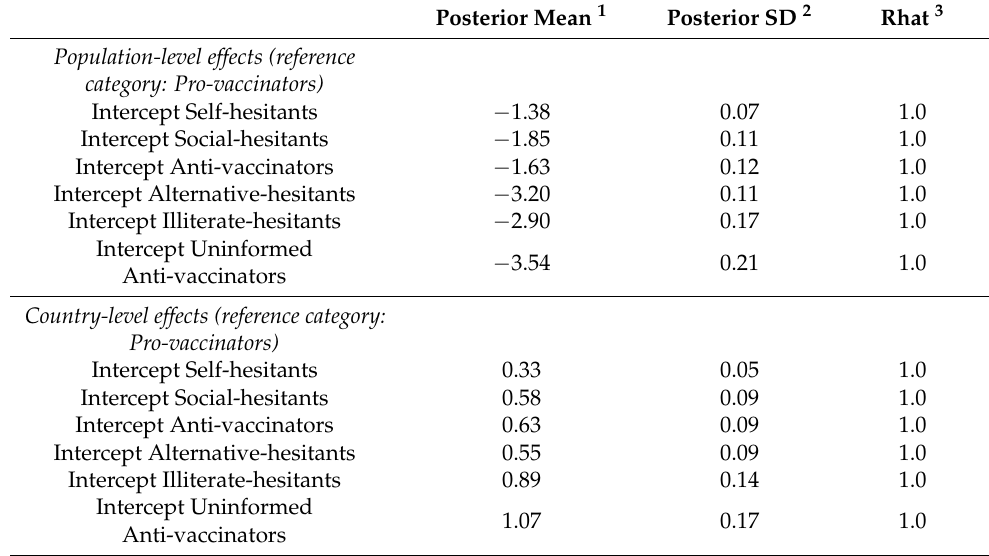
Table 3. Bayesian Multilevel Multinomial Analysis. Unconditional Mean Model